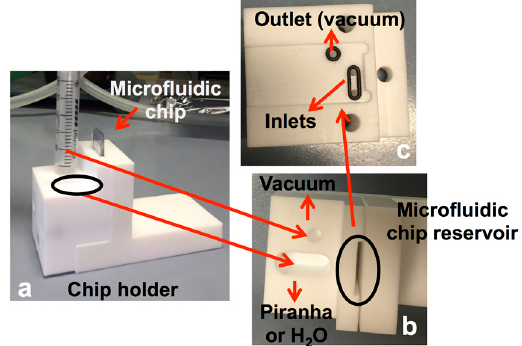
Figure 3 . Pictures of the Teflon holder for Piranha activation of the channel interior: ( a ) chip holder overview, and top view of ( b ) bowl for inserting piranha or water, vacuum connection and reservoir for inserting the microfluidic chip and ( c ) chip holder reservoir for positioning chip inlets and outlet, respectively.